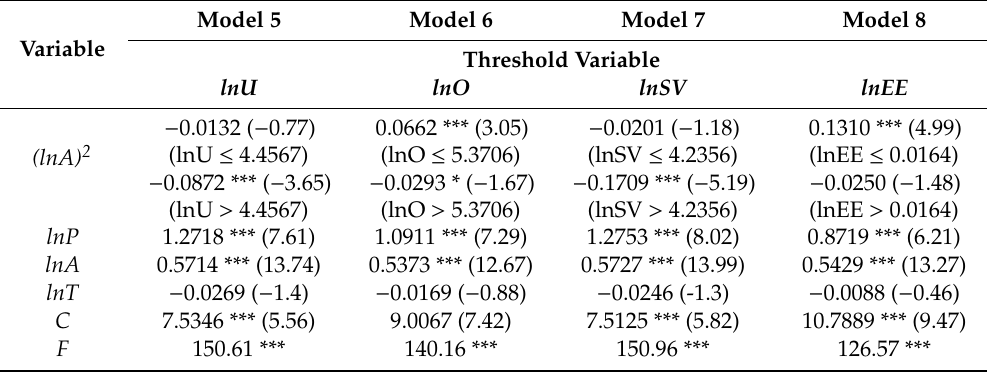
Table 8. Test results of threshold regression on the environmental Kuznets curve (EKC) under each threshold